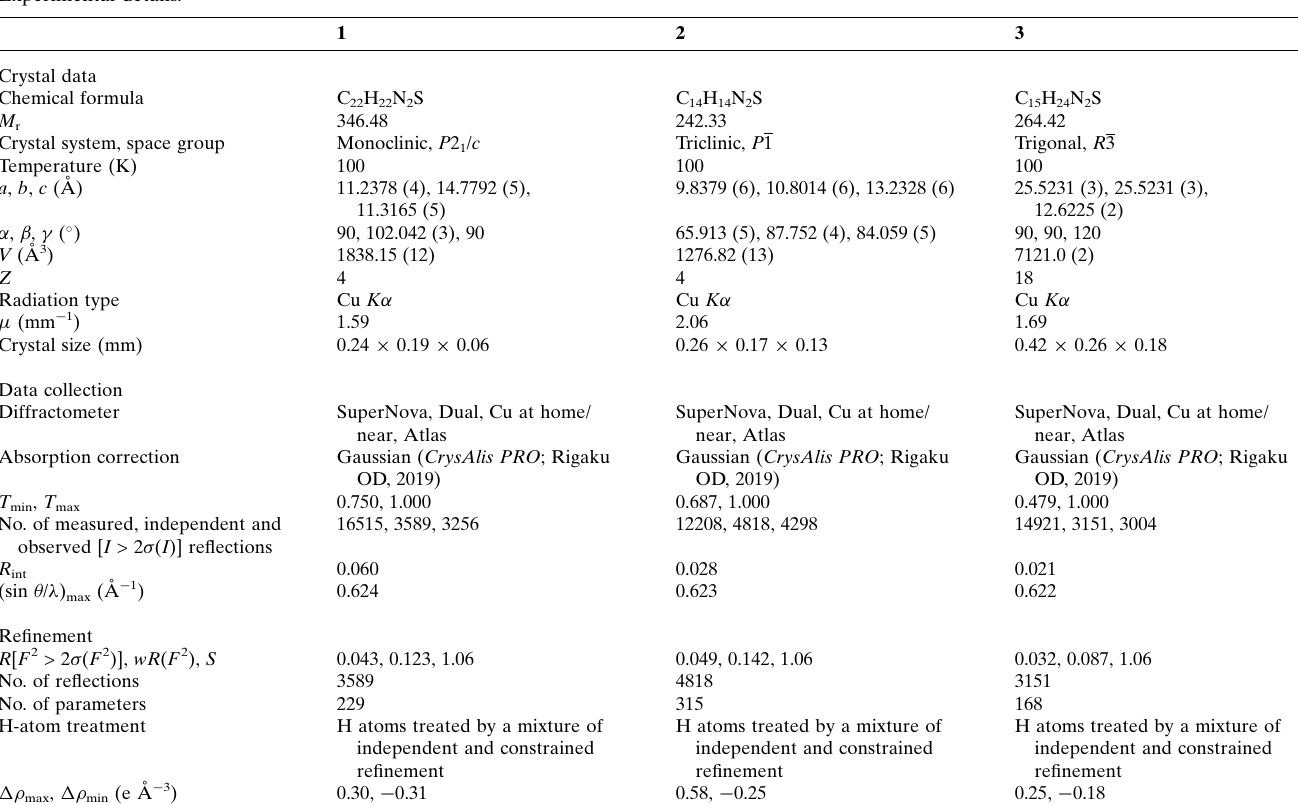
Table 4 Experimental details.